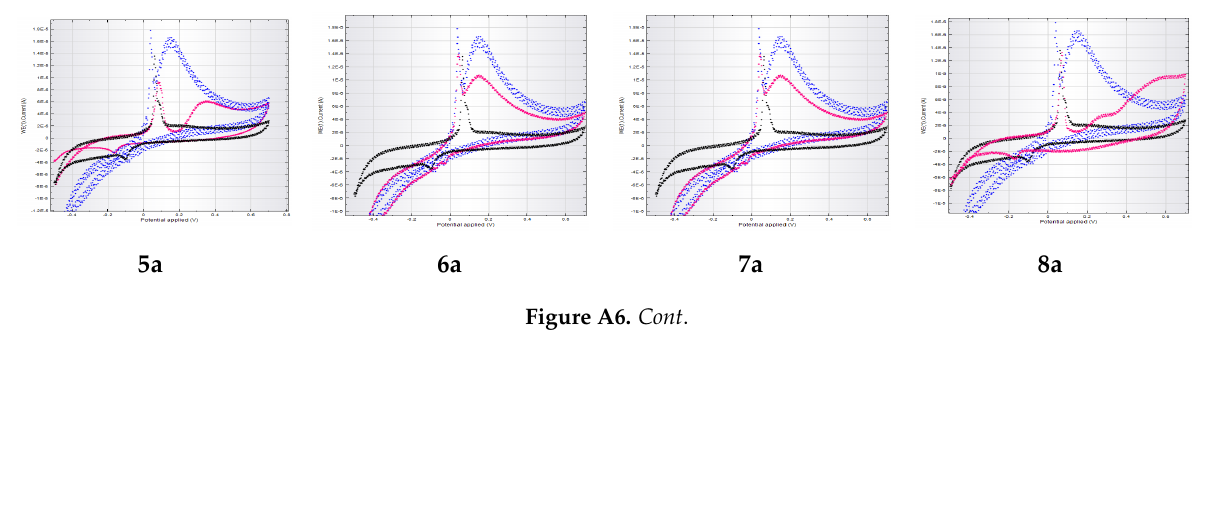
Figure A6. Overlapped CVs for the oxidation signal obtained for 0.5 mM H 2 O 2 in the absence (blue) and in the presence 0.5 mM of the novel synthesized compounds (pink) prepared in 0.1 M KCl on Au SPE. Black line: CV recorded in 0.1 M KCl. Figure A7. Overlapped CVs for the oxidation signal obtained for 0.5 mM H 2 O 2 in the absence (blue) and in the presence of 0.5 mM of the novel synthesized compounds: 5a (red) and 5b (brown) pre- pared in 0.1 M KCl on Au SPE. Black line: CV recorded in 0.1 M KCl. Figure A8. Overlapped CVs for the oxidation signal obtained for 0.5 mM H 2 O 2 in the absence (blue) and in the presence of 0.5 mM of the novel synthesized compounds: 8a (green) and 8b (orange) prepared in 0.1 M KCl on Au SPE. Black line: CV recorded in 0.1 M KCl.